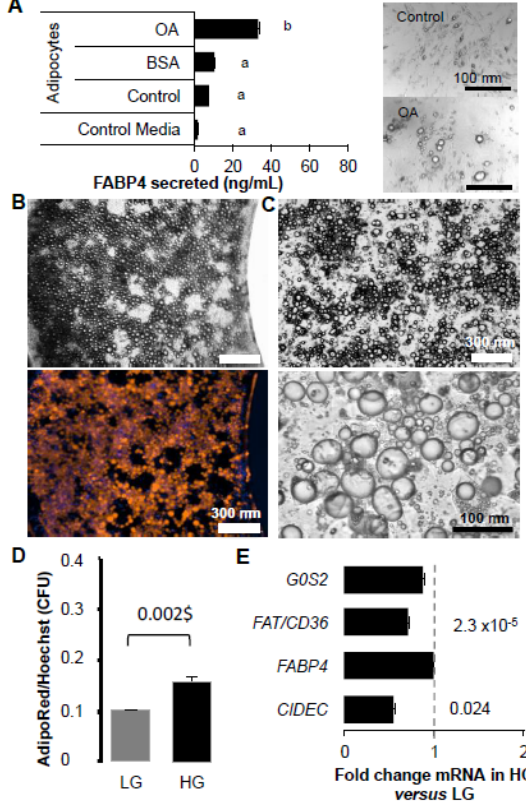
Figure 5. Lipolytic adipocytes inhibit the induction of adipogenesis. ( A ) Human adipocyte mat- uration was induced by oleic acid 10 µ M over 48 h. FABP4 accumulation in the culture media was significantly detected after 48 h. Data are presented as mean FABP4 concentrations +/ − SEM (n = 3 biological replicates in 6 wells plates). Different letters represent significant differences (ANOVA test, p -values < 0.05). ( B – D ) The 3T3-MBX adipocytes were differentiated in either 96-wells ( B ) or 6-wells inserts ( C ), for 4 days then full maturation was induced by treatment with oleic acid 10 µ M over 3 days. They were then co-cultured with approx. 80% confluent 3T3-L1 fibroblasts prepared in low glucose media. Co-cultures were performed over 3 days in either low (LG) or high glucose (HG) culture media to induce basal lipolysis in adipocytes. ( B ) Micrographs at × 4 magnification of 96 wells insert adipocytes labeled with AdipoRed (red) and Hoechst (blue). ( C ) Micrographs at objectives × 4 (upper panel) and × 20 (lower panel) of adipocytes grown in 6-well inserts. ( D ) Lipid content in 3T3-L1 fibroblasts was measured as fluorescence intensity fold change of Adipored (AR) normalized to Hoechst (H) in co-cultures vs. alone in 96-wells plates. Data are presented as mean fold changes +/ − SEM (n = 7 replicates) with Student’s t -test p -values p < 0.05 in HG vs. LG. ( E ) Transcriptional regulation of adipogenic markers in 3T3-L1 fibroblasts co-cultured with 3T3-MBX adipocytes during 3 days in high vs. low glucose media. Data are presented as mean fold changes mRNA (normalized to standard HPRT gene) of HG versus LG condition +/ − SD of 3 replicates (6-wells inserts) with significant Student’s t -test p -values p <